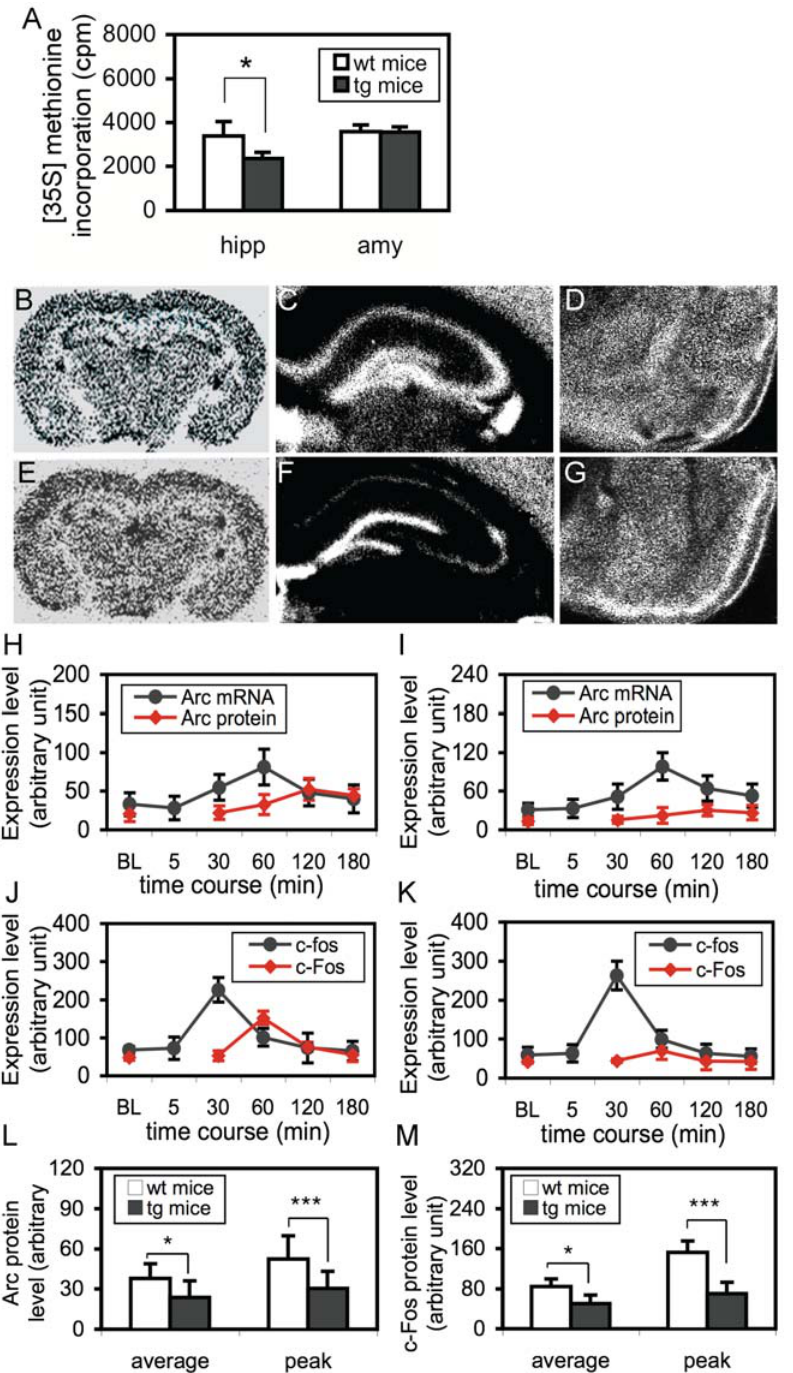
Figure 5. Protein synthesis inhibition in the hippocampus, but not amygdala, of hip-eEF-2K-tg mice. A . Quantitative analysis of [ 35 S]- methionine incorporation into proteins in the hippocampi (hipp) and amygdalae (amy) from wild-type (wt; n=6) and hip-eEF-2K-tg (tg) mice (n=7). *, p , 0.05, Student’s t test. B and E . Representative autoradiography microphotographs showing protein synthesis inhibition in coronal brain sections from wild-type (B) and hip-eEF-2K-tg mice (E). C and F . A higher magnification of microphotographs showing protein synthesis inhibition in the hippocampus of hip-eEF-2K-tg mice (F), compared to wild-type mice (C). D and G . A higher magnification of microphotographs showing no observable protein synthesis inhibition in the amygdala of hip-eEF-2K-tg mice (G) compared to wild-type mice (D). H and I . Expression of Arc mRNA (black line) and Arc protein (red line) in the hippocampi from wild-type (H; n=5 in each group) and hip-eEF-2K-tg mice (I; n=5 in each group). BL: basal line from mice treated with vehicle. J and K . Expression of c-fos mRNA (black line) and c-Fos protein (red line) in the hippocampi from wild-type (J; n=4 in each group) and hip-eEF-2K-tg mice (K; n=4 in each group). BL: basal line from mice treated with vehicle. L and M . Quantitative analysis of the expression of Arc protein (L) and c-Fos protein (M) in hippocampi from mice after KA injection at the average level and peak level. *, p . 0.05, Student’s t test, ***, p , 0.001, post hoc test, compared between wild-type (wt) and hip-eEF-2K-tg (tg) mice.